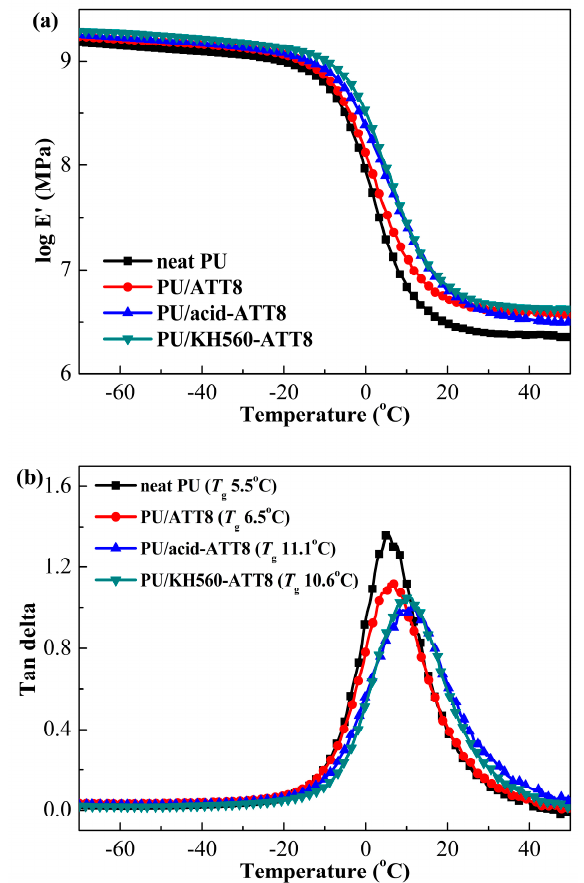
Figure 2. Dynamic mechanical spectra in terms of logarithmic E ′ ( a ) and tan δ ( b ) for neat PU and